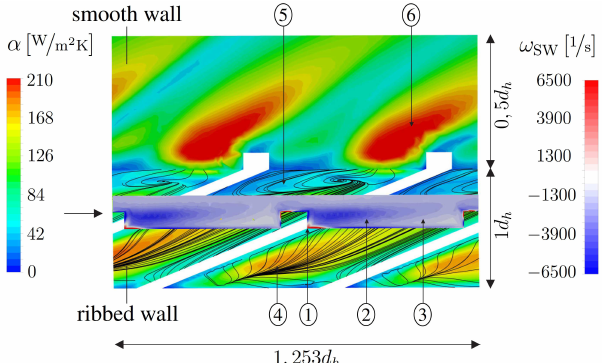
Figure 6. Heat transfer coefficient, vorticity parallel to main flow direction at 7-th